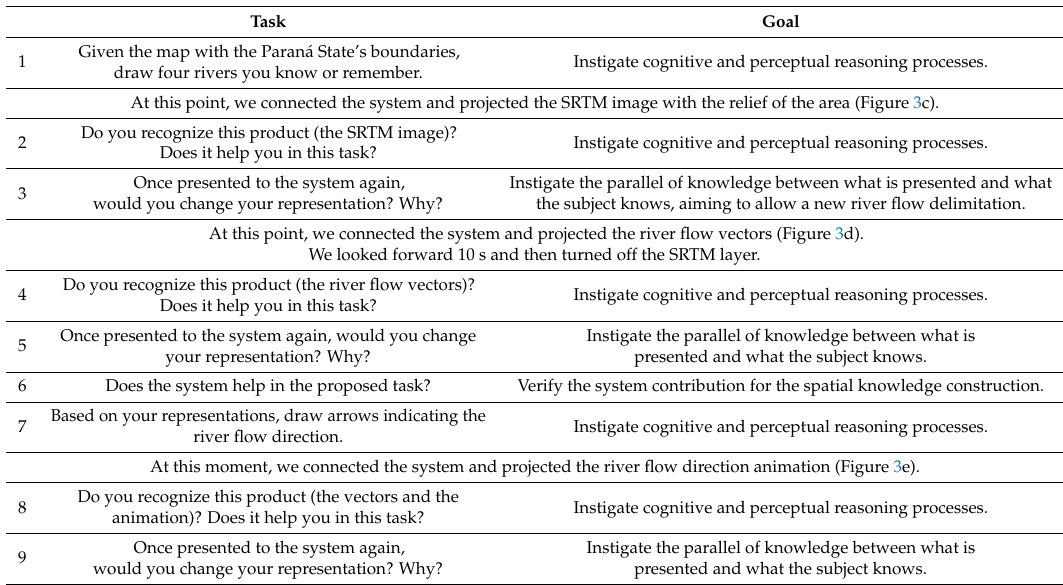
Figure 3. Layers of Information Shown in Step 2 using the AR System. ( a ) original physical map of Paraná; ( b ) map augmented with the addition of digital information of the state of the Paraná boundary; ( c ) SRTM information added; ( d ) addition of the hydrographic information; and ( e ) with the addition of animation indicating the direction of flow of rivers. (Developed by the authors). Table 3. Second Stage Tasks.